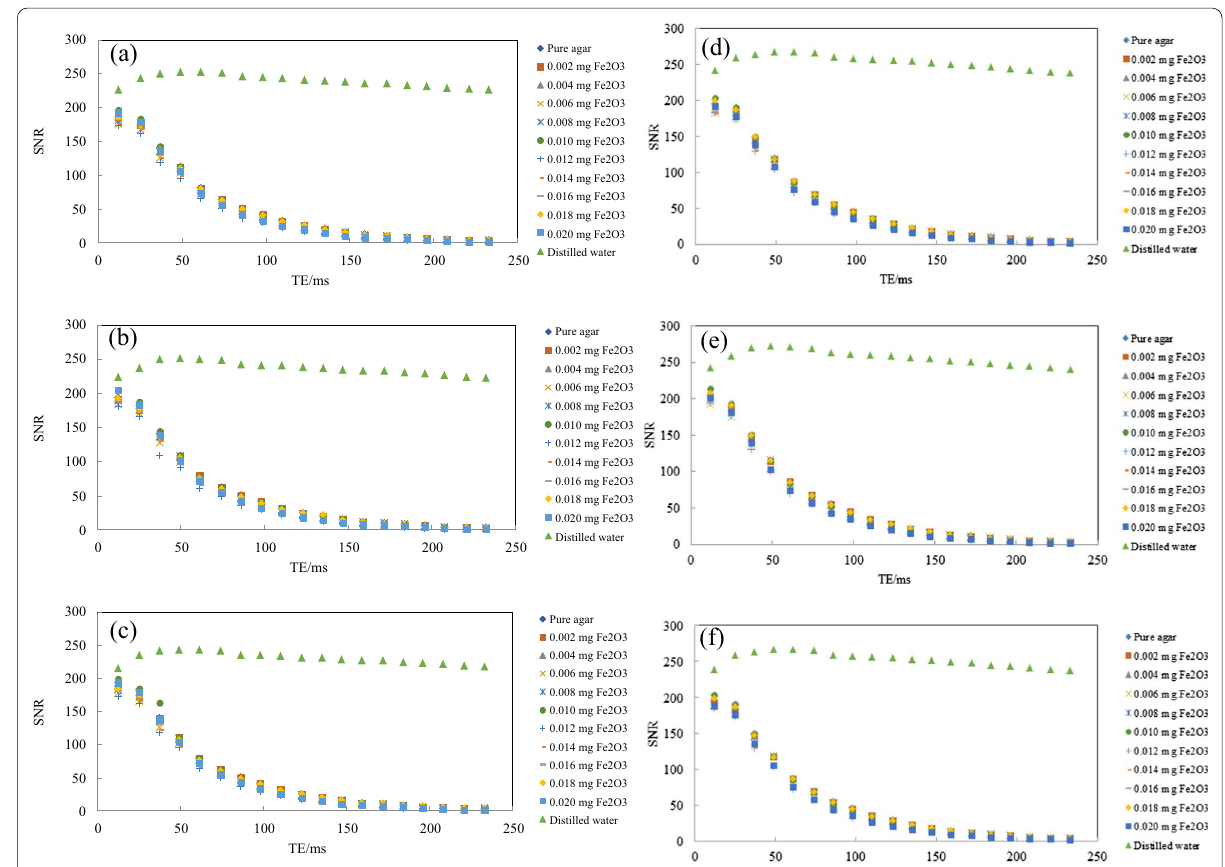
Fig. 2 T2 curves obtained from the phantoms at TP1 (left) by using a 1 ROI, b 3 ROIs and c 25 ROIs, and at TP2 (right) by using d 1 ROI, e 3 ROIs and f 25 ROIs